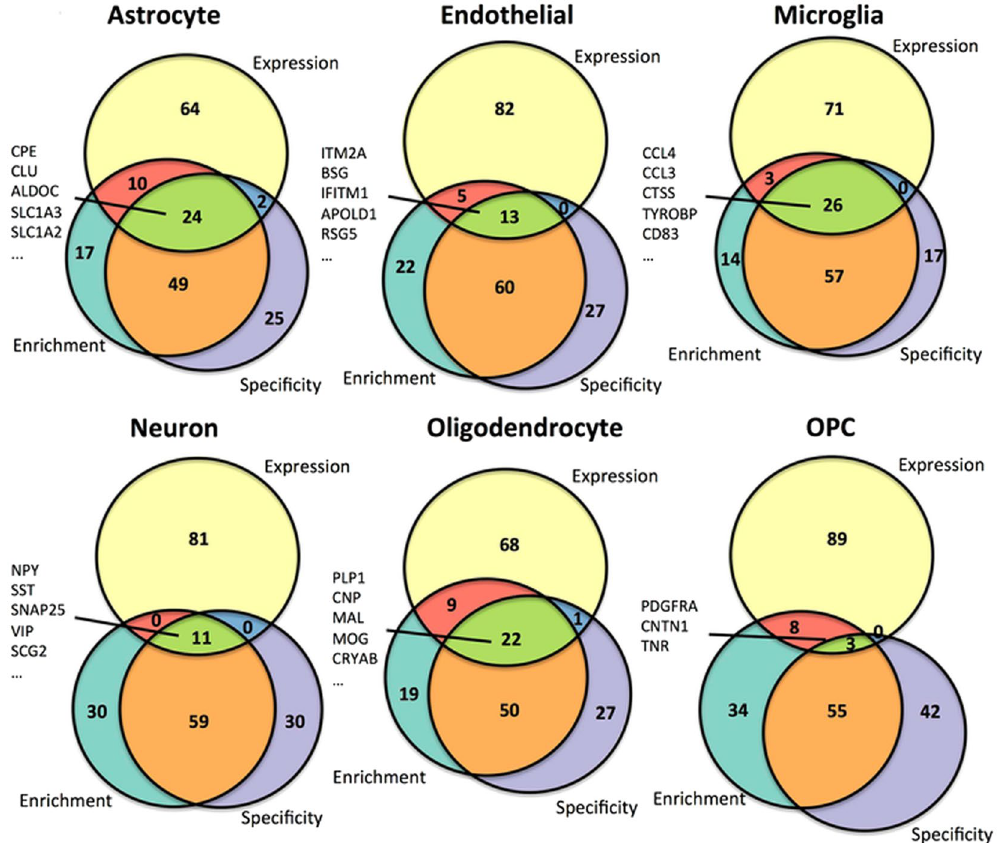
Figure 5. Intersections among the top genes for three cell type associated measures consensus rankings across all cell types. The top 100 genes ranked across both mouse and human data sets for each of the cell type measures are intersected using approximately proportional Venn diagrams for each of the astrocyte ( a ), endothelial cell ( b ), microglia ( c ), neuron ( d ), oligodendrocyte ( e ), and oligodendrocyte precursor cell ( f ) signatures. The Venn diagrams were generated using the R package Vennerable (version 3.0). The 5 genes with the top expression values in each of the cell types that intersect in all three of the top 100 gene sets are listed, with the exception of OPCs, for which all 7 of the genes with intersections between the three measures are